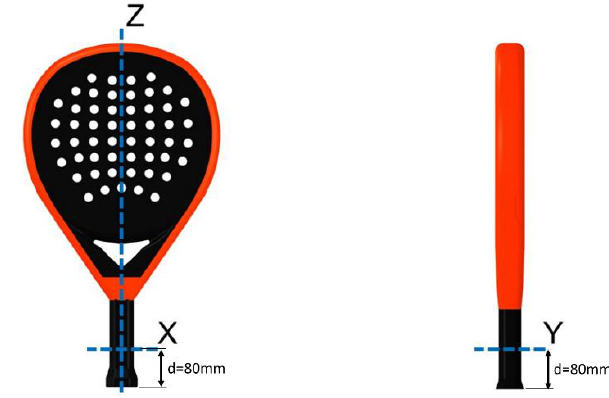
Figure 1. Padel racket and its rotation axes.